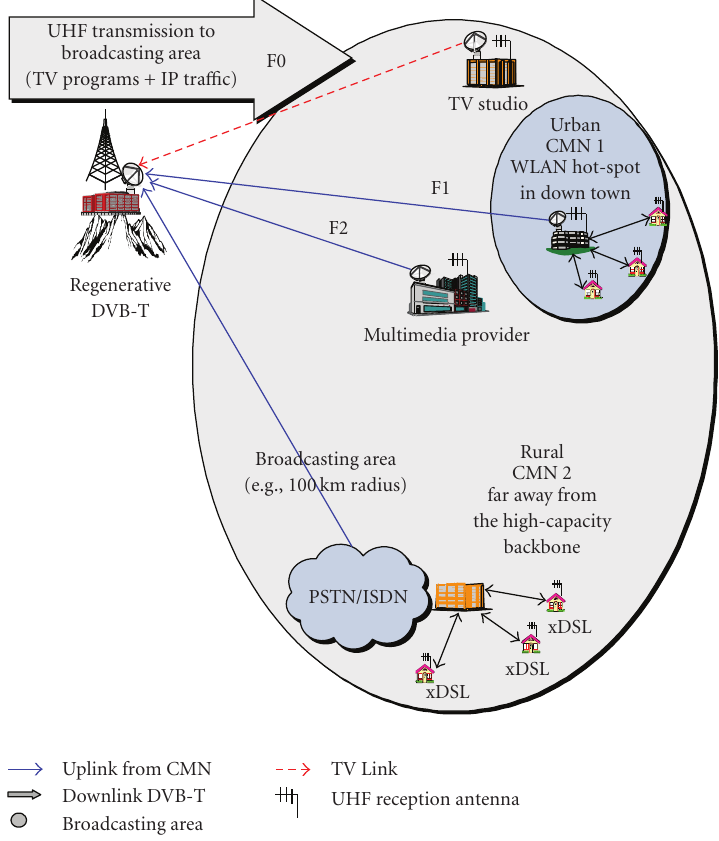
Figure 2: Overall architecture of the terrestrial DVB/IP